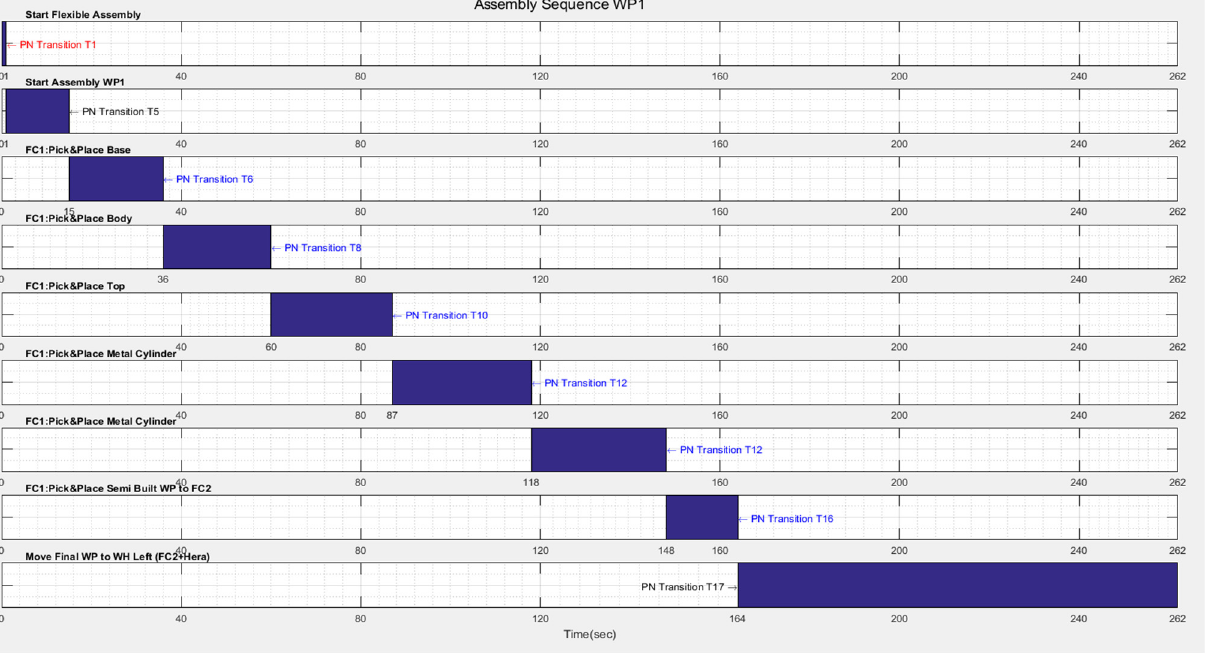
Figure 26. Results for discrete places and transitions on Assembly WP2.